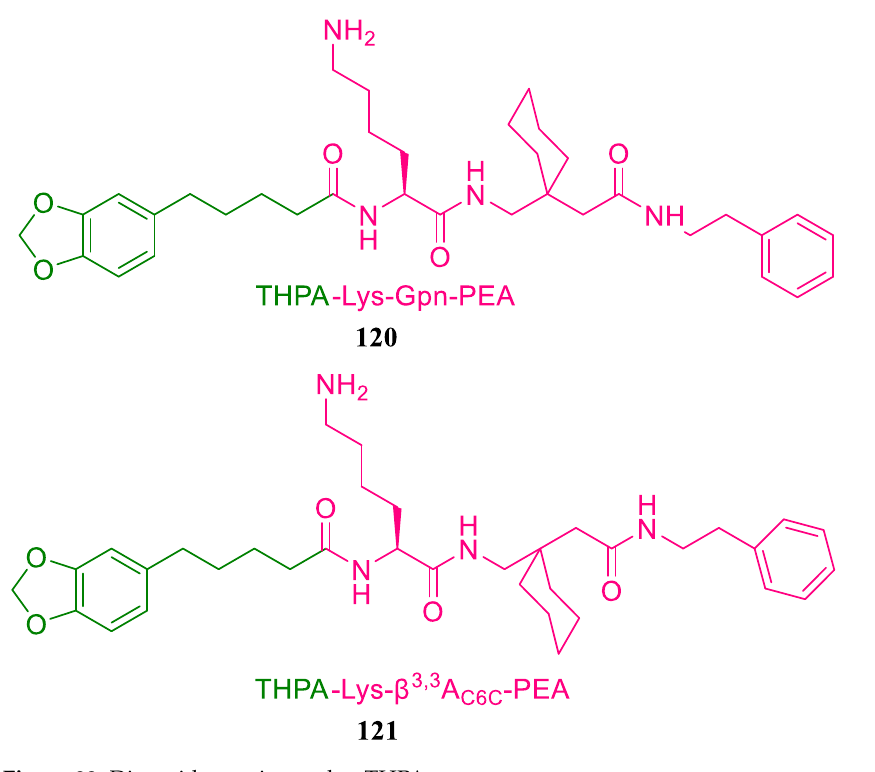
Figure 98. Dipeptides conjugated to THPA.